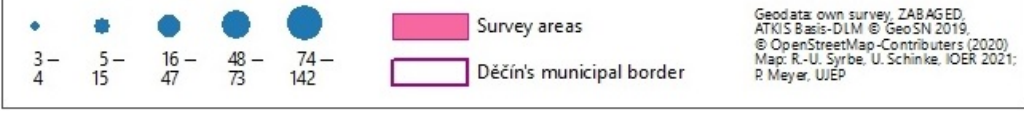
Figure 7. Survey areas in D ěč ín and the most popular green areas (named at least three times in an open question) (source: authors’ elaboration).